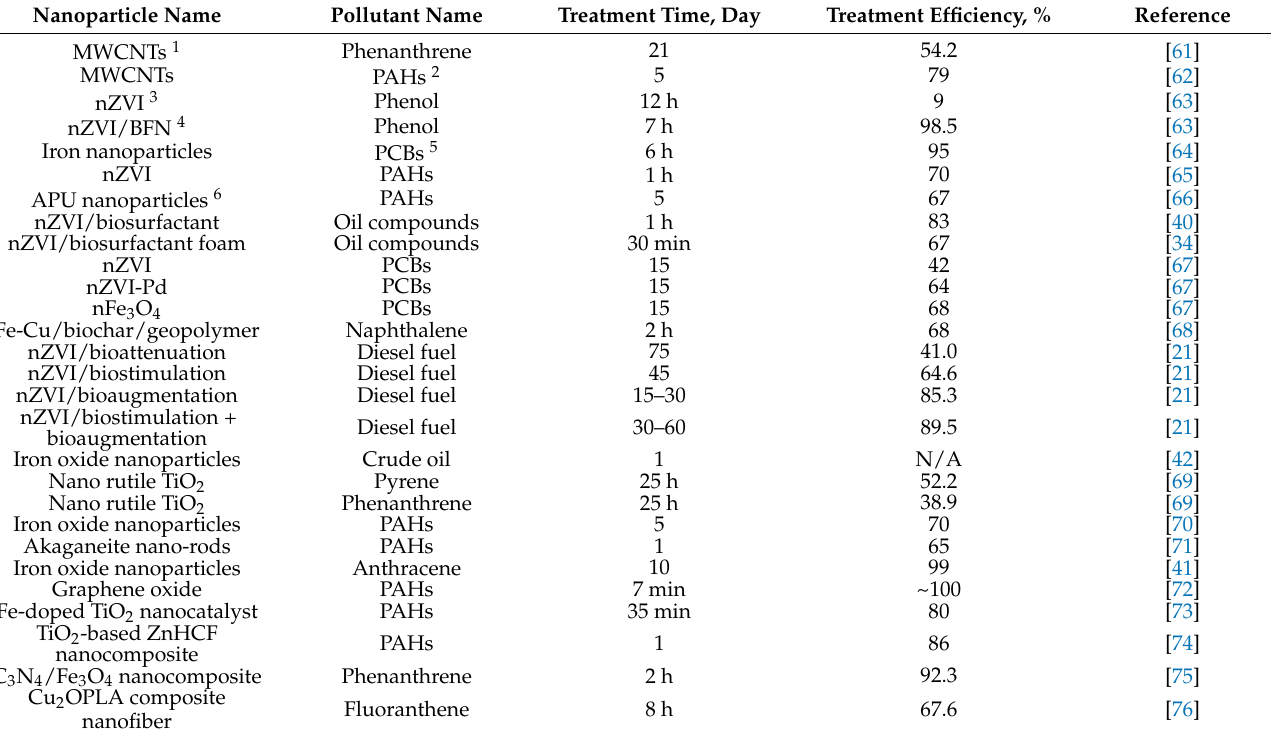
Table 1. Use of selected nanoparticle for remediation of oil pollutants from soil.